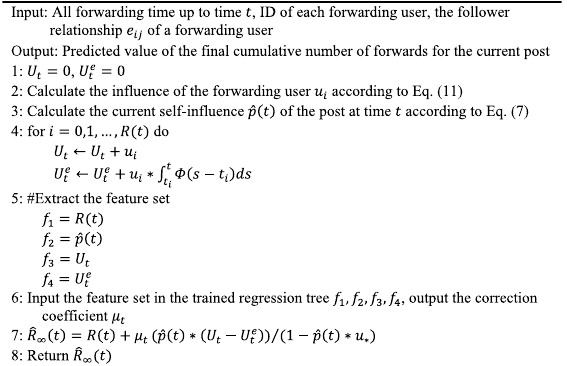
Algorithm 1. Final scale prediction of an information